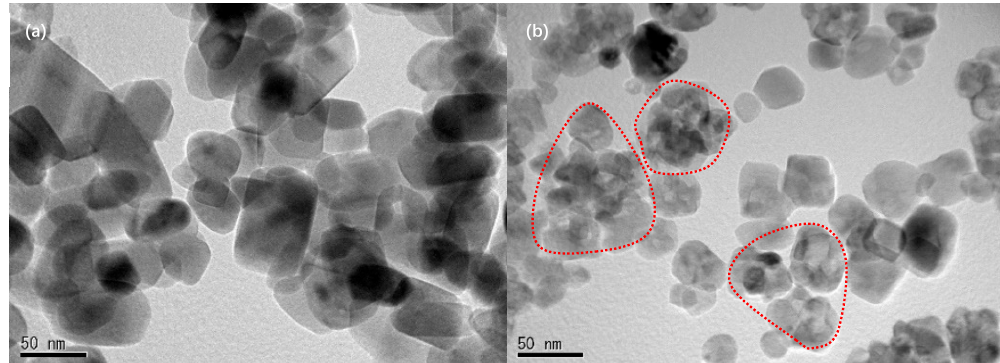
Figure 3. TEM images of RuO 2 /TiO 2 -r ( a ) and RuO 2 /TiO 2 -a ( b ).